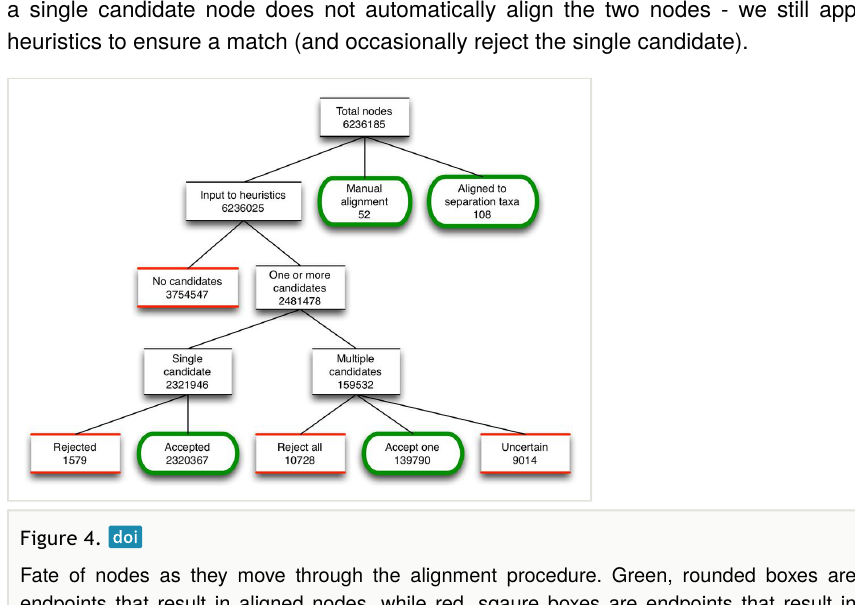
Fate of nodes as they move through the alignment procedure. Green, rounded boxes are endpoints that result in aligned nodes, while red, sqaure boxes are endpoints that result in unaligned